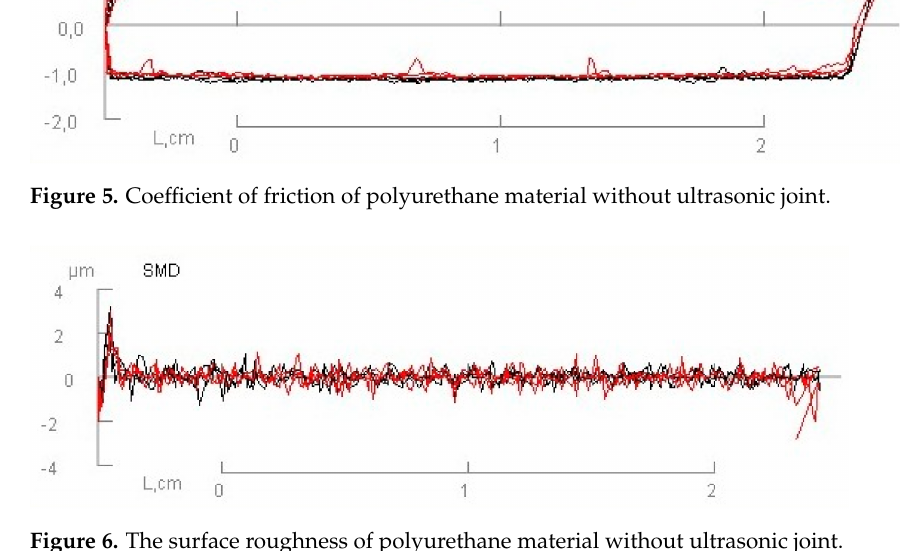
Figure 6. The surface roughness of polyurethane material without ultrasonic joint.